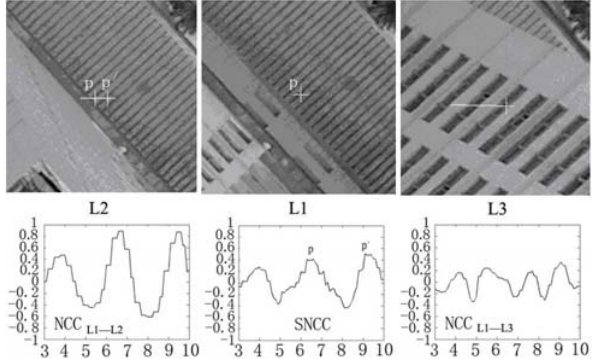
Figure 10. Experiment results by projection rays constraint matching